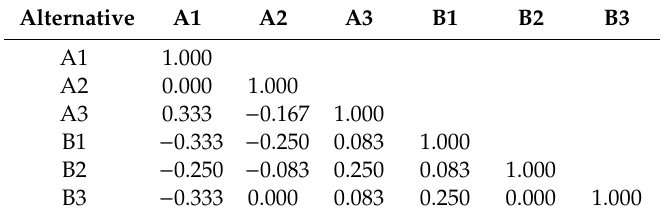
Table 3. Correlation between attributes of the experimental design alternatives.